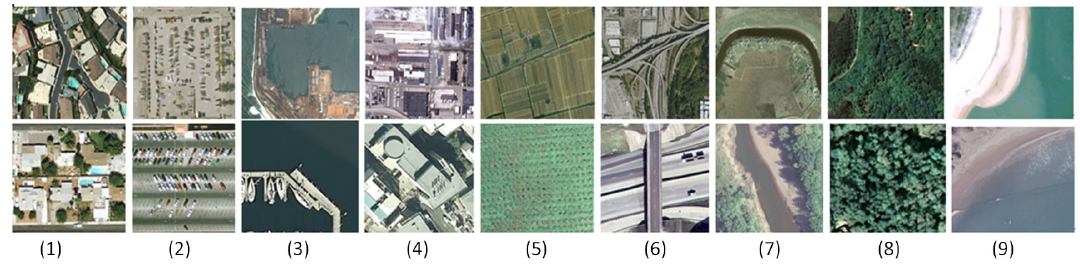
Figure 5. Nine common categories of satellite scenes from WHU-RS19 dataset (top row) and aerial scenes from UC Merced dataset (bottom row): ( 1 ) residential; ( 2 ) parking lot; ( 3 )